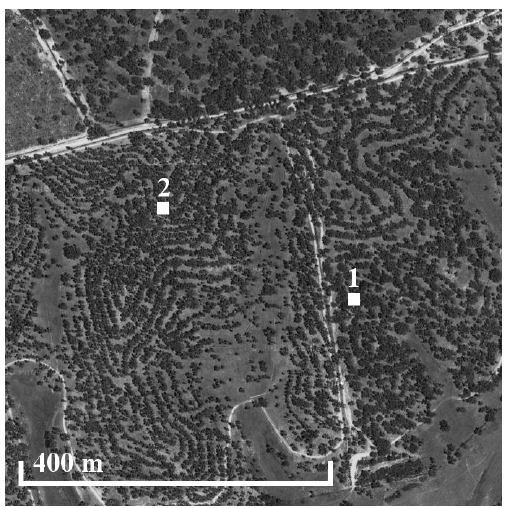
Figure 1. Satellite image of the study site ( © Google Maps, 2013). (1) Position of the overstorey tower. (2) Position of the understorey